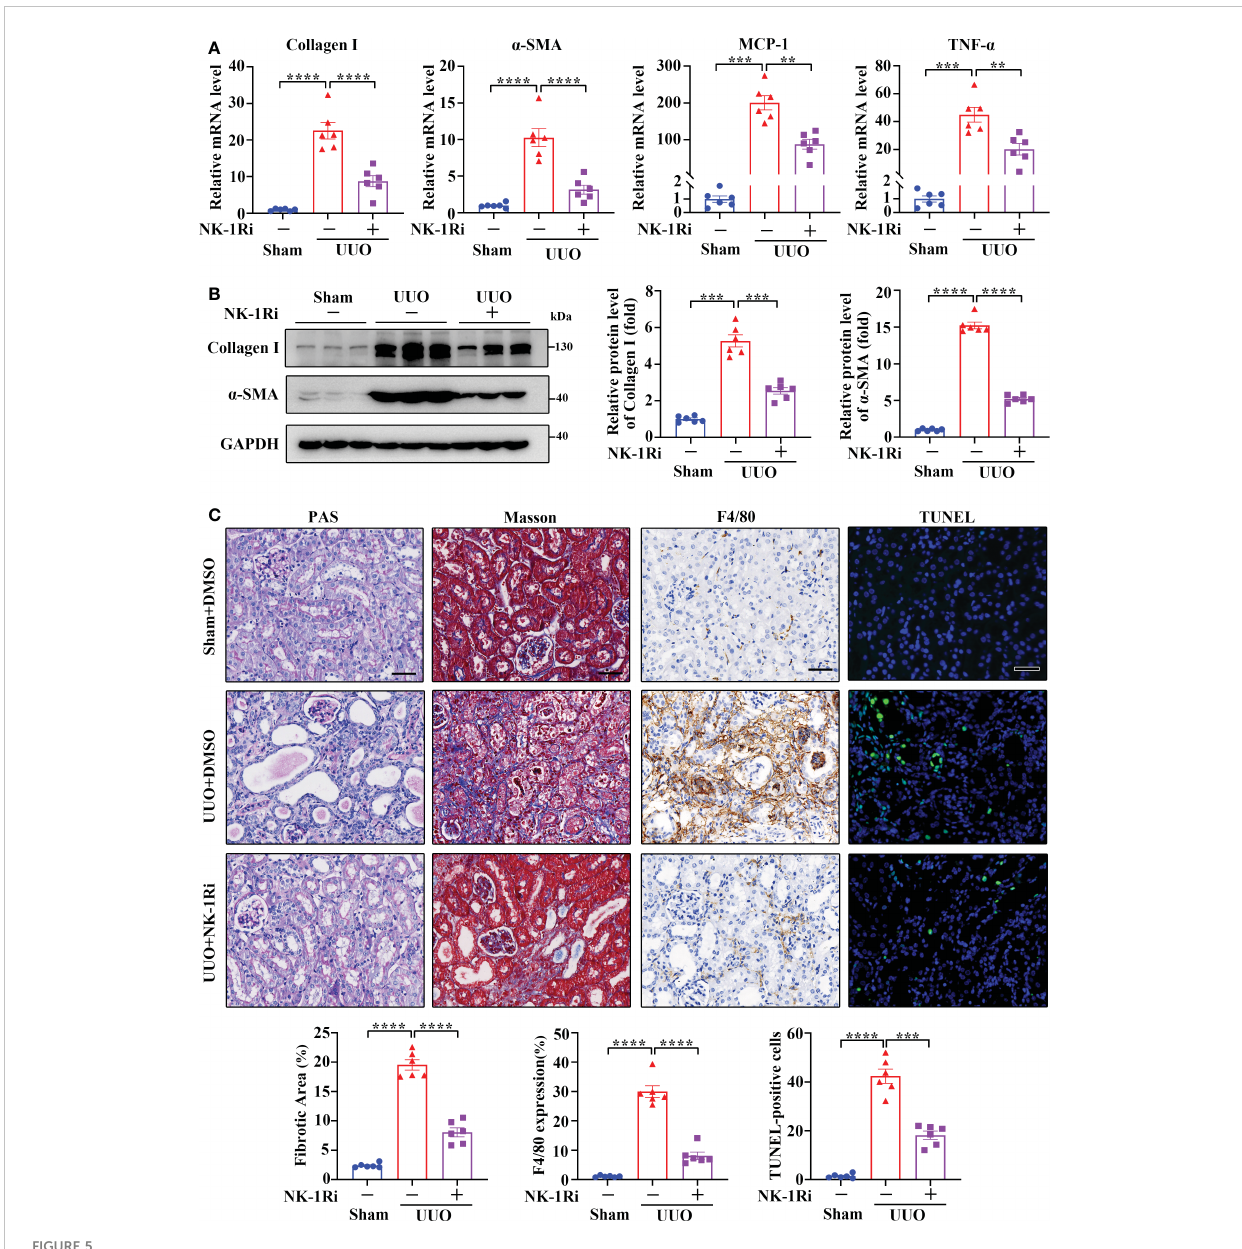
FIGURE 5 Inhibition of NK-1R with a pharmacological antagonist attenuated UUO-induced renal fi brosis, in fl ammation, and apoptosis. (A, B) RT-qPCR (A) and Western blotting (B) showed that the inhibition of NK-1R antagonized the UUO-induced increase in Collagen I, a -SMA, MCP-1, and TNF- a at the mRNA and/or protein levels in renal cortical tissues on day 14 after UUO. For B, representative images (left panels) and quantitative data (right panels) are shown. (C) PAS, Masson ’ s trichrome, F4/80 immunochemistry staining, and TUNEL analysis displayed that the inhibition of NK-1R impeded renal fi brosis, in fi ltration of F4/80-positive in fl ammatory cells, and apoptosis mediated by UUO surgery. Representative images (upper panels) and quantitative data (lower panels) are shown. For (A – C) , sham and UUO mice were administered intraperitoneally with vehicle (DMSO) or a speci fi c NK-1R inhibitor (NK-1Ri) SR140333 (1 mg/kg body weight) every day for 14 days. + or − , with (+) or without ( − ) the indicated treatment. TUNEL- positive cells were counted by fl uorescence microscopy in ten randomly selected high-power fi elds per kidney section. Scale bar, 50 µm. Data are shown as mean ± SEM from groups of six mice. ** p < 0.01; *** p < 0.001; **** p <